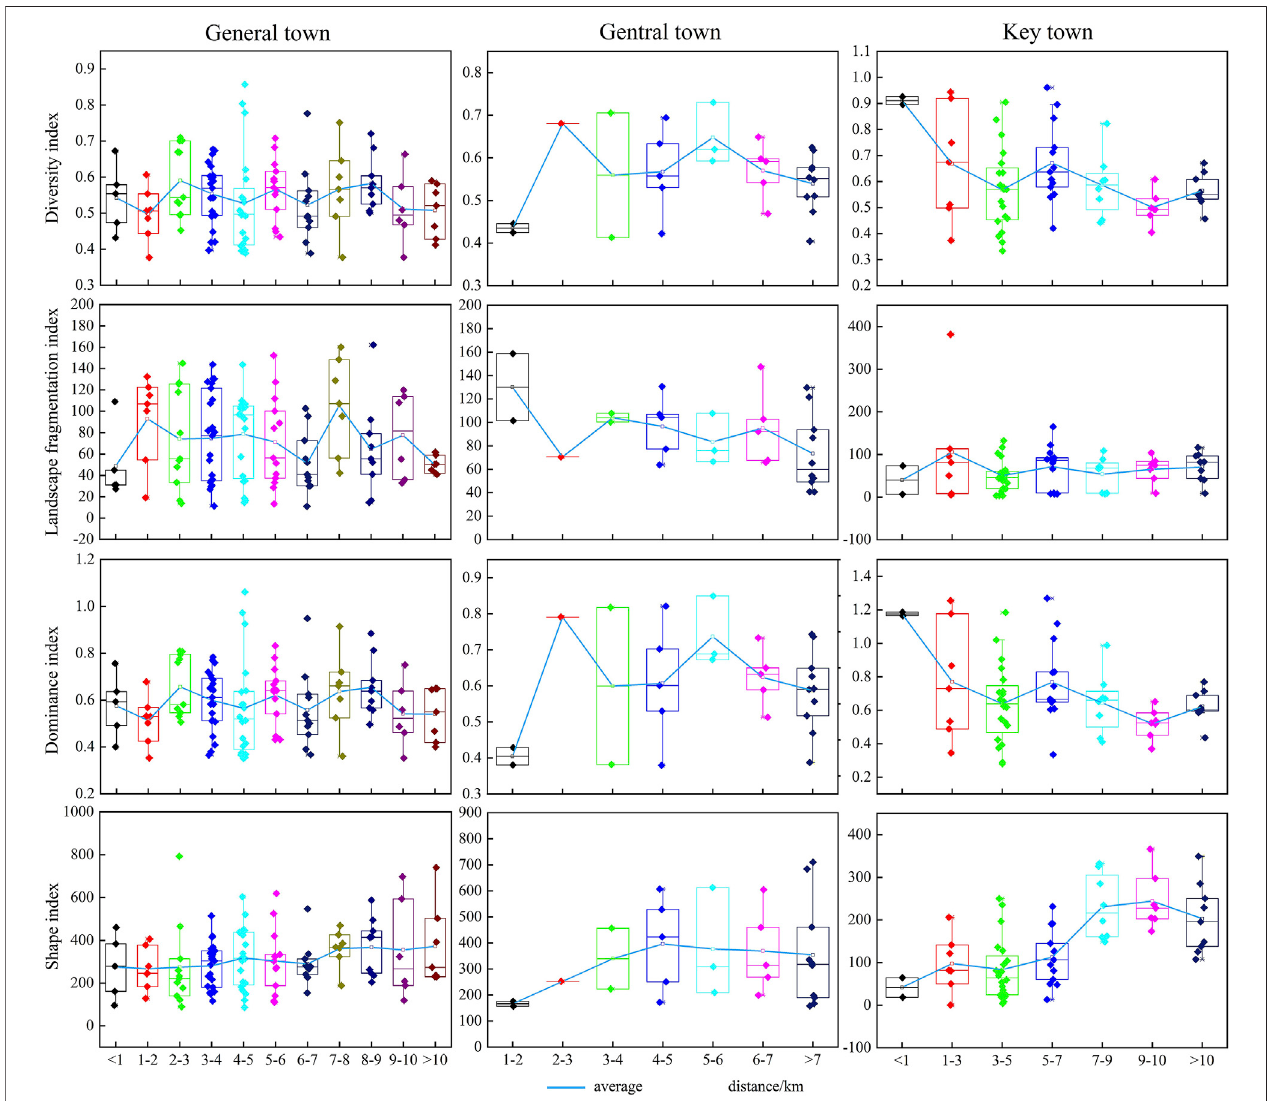
FIGURE 7 | Township gradient differentiation of the landscape index of